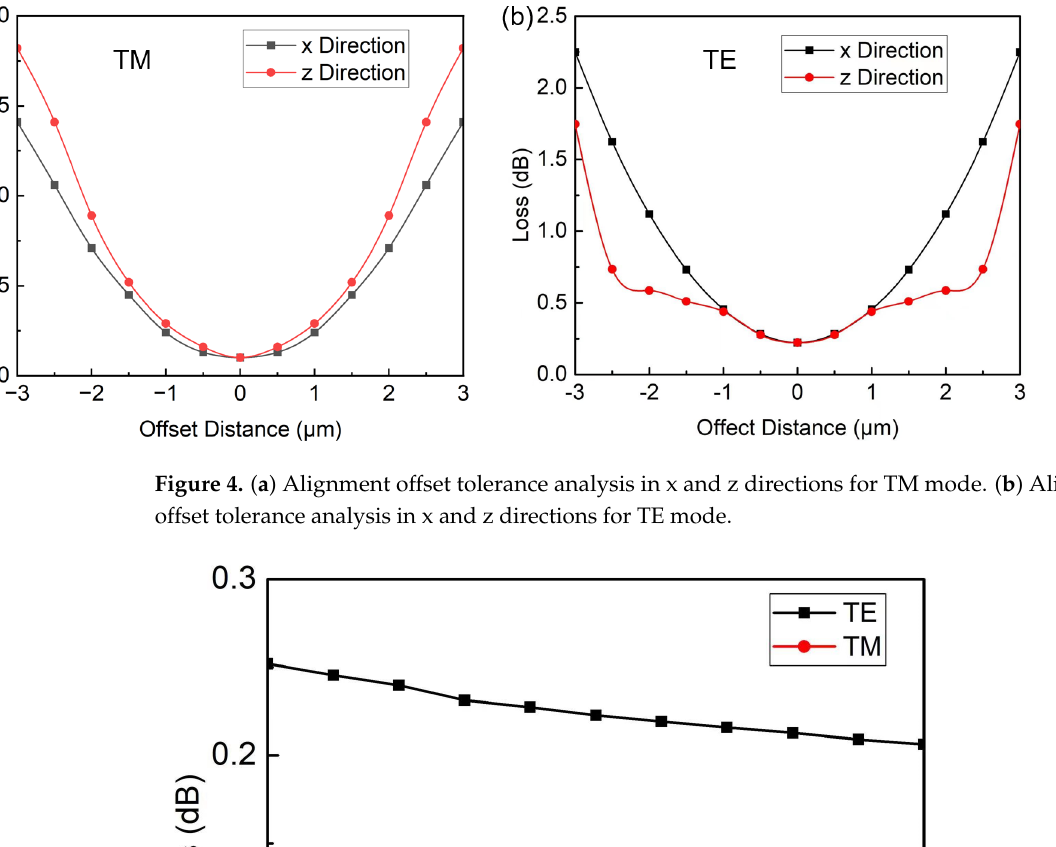
Figure 4. ( a ) Alignment offset tolerance analysis in x and z directions for TM mode. ( b ) Alignment offset tolerance analysis in x and z directions for TE mode.